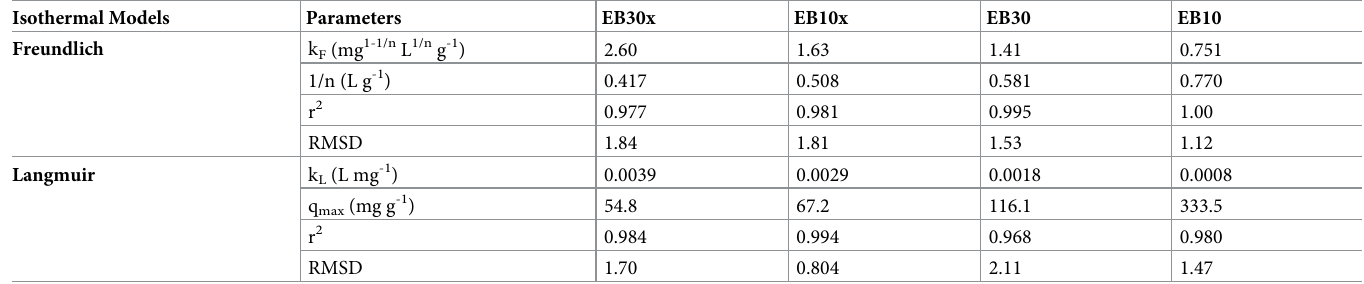
Table 2. Parameters of Langmuir and Freundlich isotherms for copper biosorption by EB30x, EB10x, EB30 and EB10. Conditions: Initial copper concentrations ranging from about 50 to 1050 mg L -1 ; contact time = 240 min; pH = 5.0 ± 0.1; agitation speed = 150 rpm; temperature = 25 ± 2˚C; biosorbent dosage for EB10 = 0.333 g L - 1 and for EB30 = 1.0 g L -1 . Isothermal Models